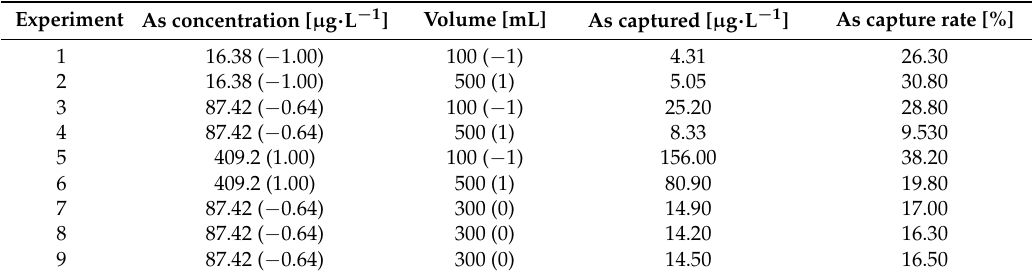
Figure 9. ( a ) Standardized Pareto chart for As capture rate, due to Q/VTMSO-SiO 2 filler treatment (where: A, As concentration; B, Eluted volume; and AB, AA and BB interactions. Blue line represents critical t -value, 95% confidence); and ( b ) estimated response surface. According to the statistical significance of the variables, the equation of the model is: (cid:1827)(cid:1871) (cid:1829)(cid:1853)(cid:1868)(cid:1872)(cid:1873)(cid:1870)(cid:1857) (cid:1844)(cid:1853)(cid:1872)(cid:1857) = 10.2 − 6.36 × (cid:1828) + 18.6 × (cid:1827)^2 − 3.90 × (cid:1827) × (cid:1828)((cid:1844) (cid:2870) = 65.57) . The optimum As capture predicted for Q/VTMSO-SiO 2 fill was 39.24%. The optimum experimental conditions were a volume of 100 mL and a concentration of 409.2 ppb. In this way, the